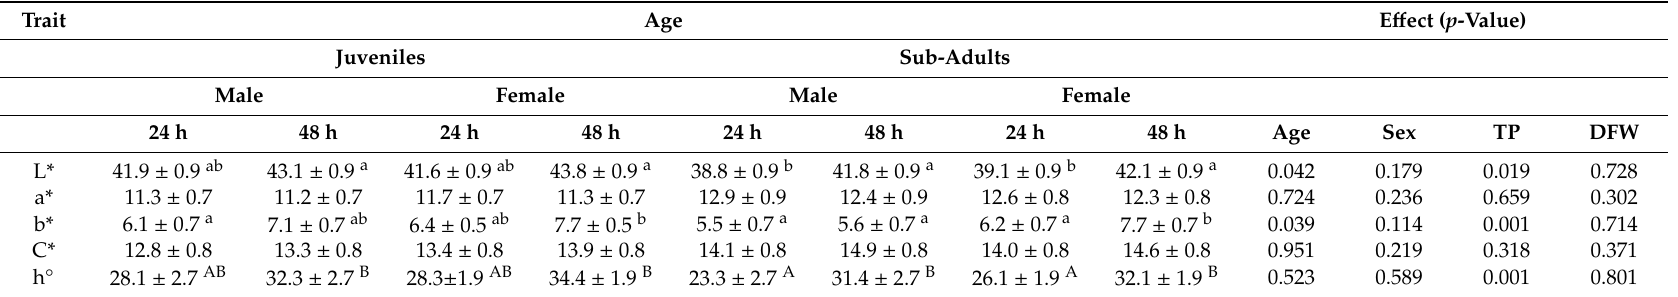
Table 4. The colour parameters of m. semimembranosus from the wild boar (mean ± SD).